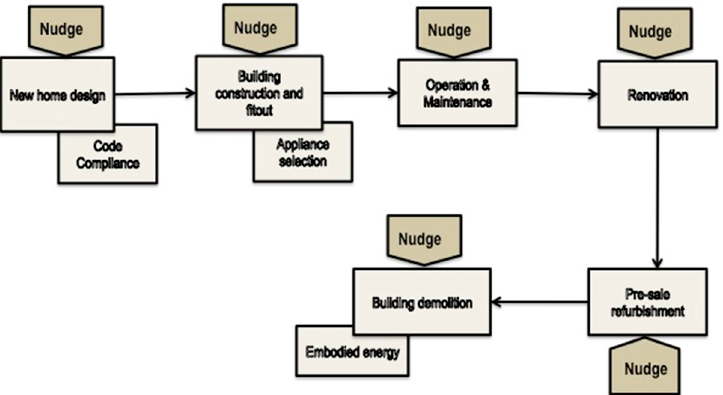
Figure 3. Key decision points in the residual building ownership lifecycle that present opportunities for the application of BE change management tools, such as nudging, in order to more e ff ectively achieve desired policy